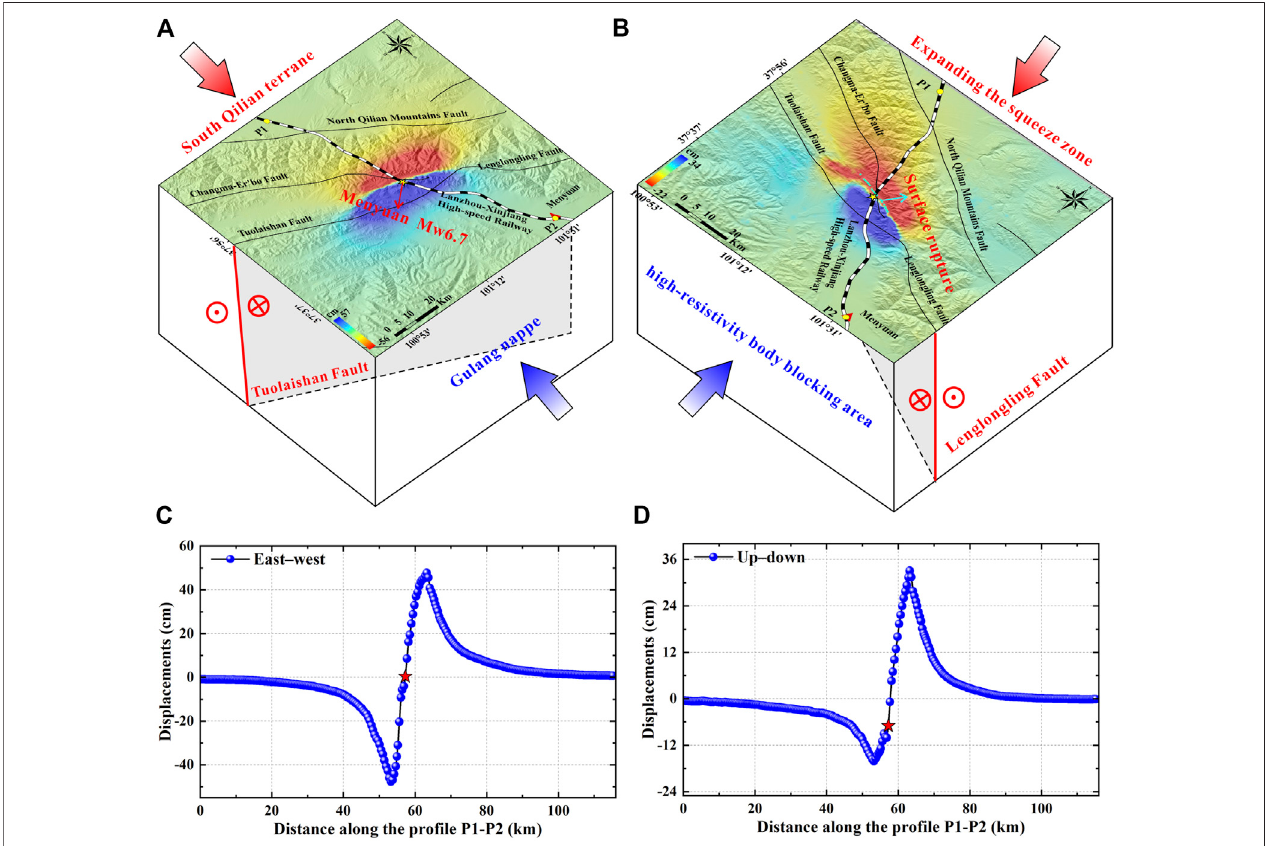
FIGURE 10 | The (A) east-west and (B) up-down ground displacement components due to the 2022 Menyuan earthquake. Cross-sections along LHSR P1-P2 in (C) east-west and (D) up-down deformations.